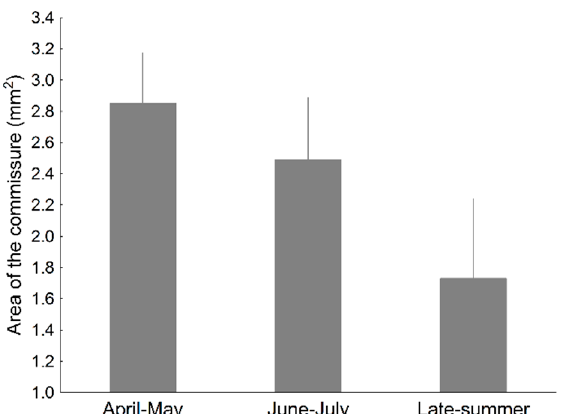
Figure 7. Average values of commissure area (with SE) in the lizard P. algirus , according to season.